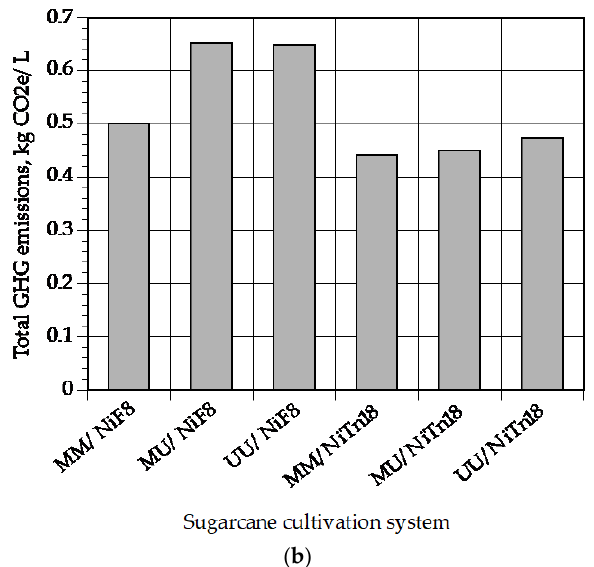
Figure 3. Total energy inputs ( a ) and total greenhouse gas (GHG) emissions ( b ) to produce 1 L of ethanol. MM, mulching at planting and every ratooning; MU, mulching only at planting; UU, untreated, i.e., no mulching at all. NiF8, a conventional cultivar; NiTn18, a cultivar characterized by improved yielding capacity and cold tolerance.